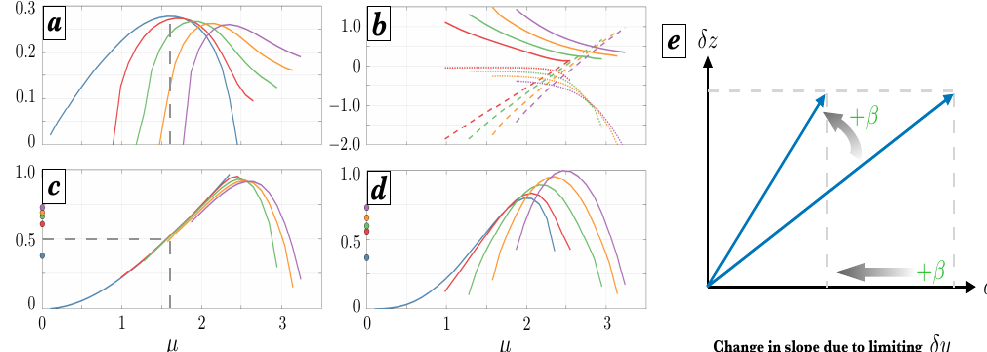
Figure 2. ( a ) Diagnosed growth rates, ( b ) behavior of the terms in (16), ( c ) values of C b , and ( d ) values of C b weighted by growth rate, as functions of the nondimensional wavenumber µ . The gray dashed lines indicate the most unstable Eady wave at µ = 1.61. The legend for these plots is the same as in Figure 1. ( e ) Schematic showing the steepening of the buoyancy flux slope when meridional parcel excursions δ y are limited as β ∗